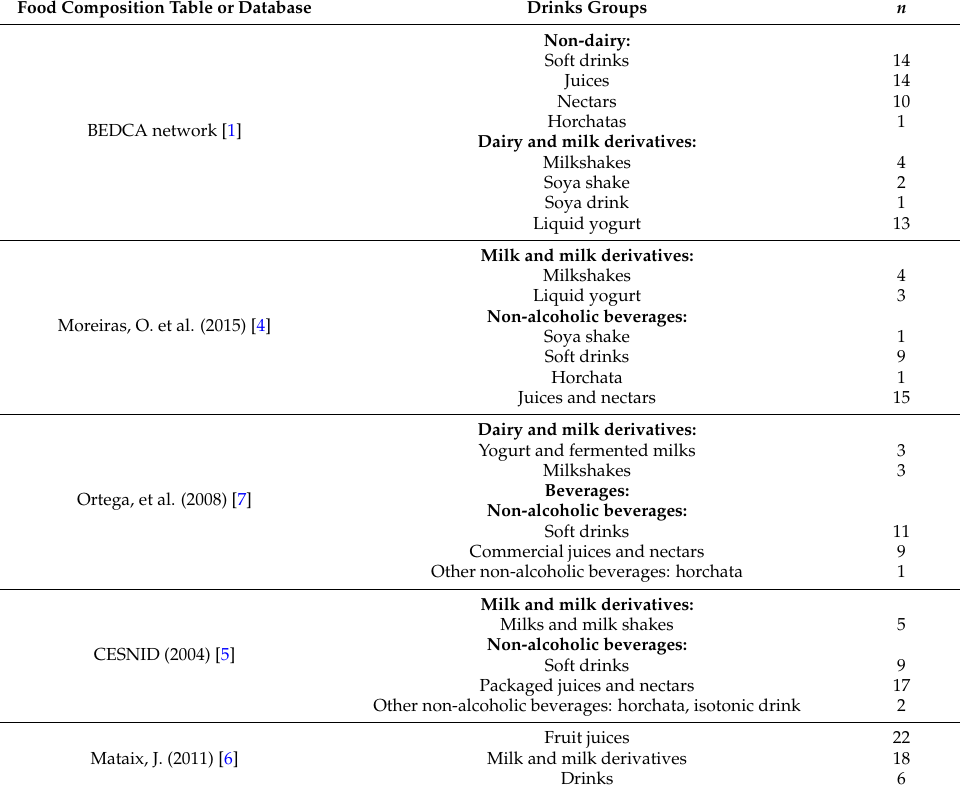
Table 9. Classification of non-alcoholic beverages in the Spanish Food Composition Tables. Food Composition Table or